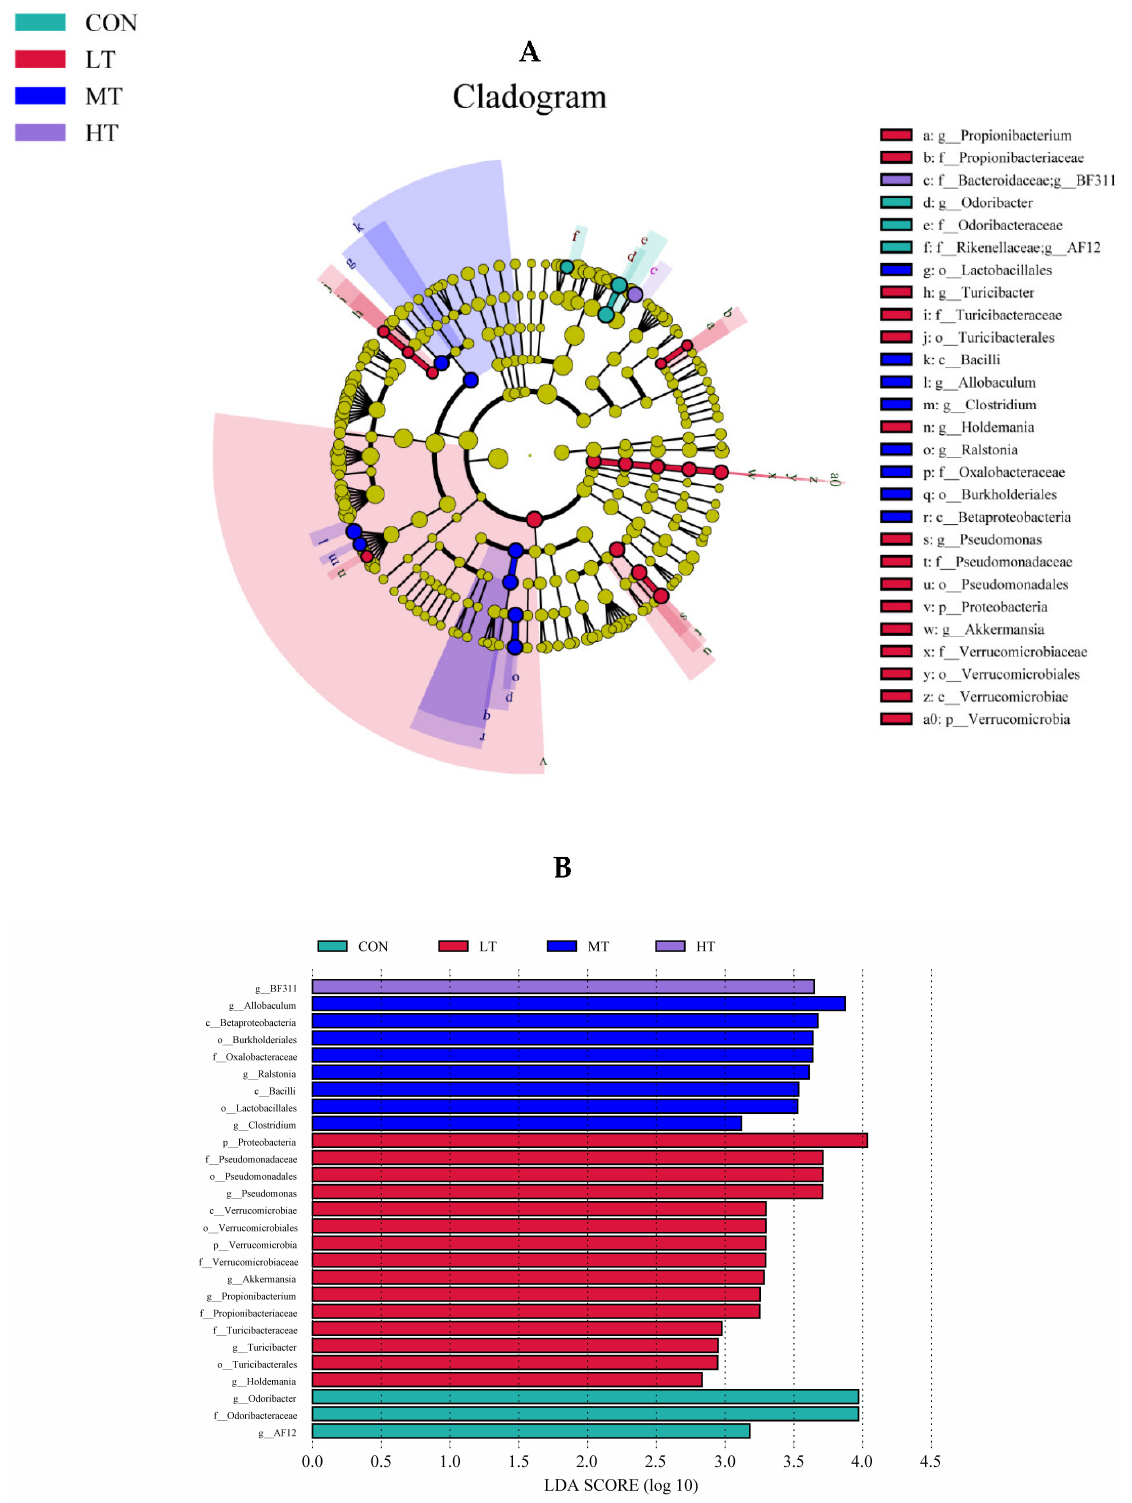
Figure 4. ( A ) LEfSe (linear discriminant analysis Effect Size) cladogram comparing bacterial communities among the four groups. ( B ) Histogram of LDA score calculated for each taxon ranging from phylum to genus among the four groups.